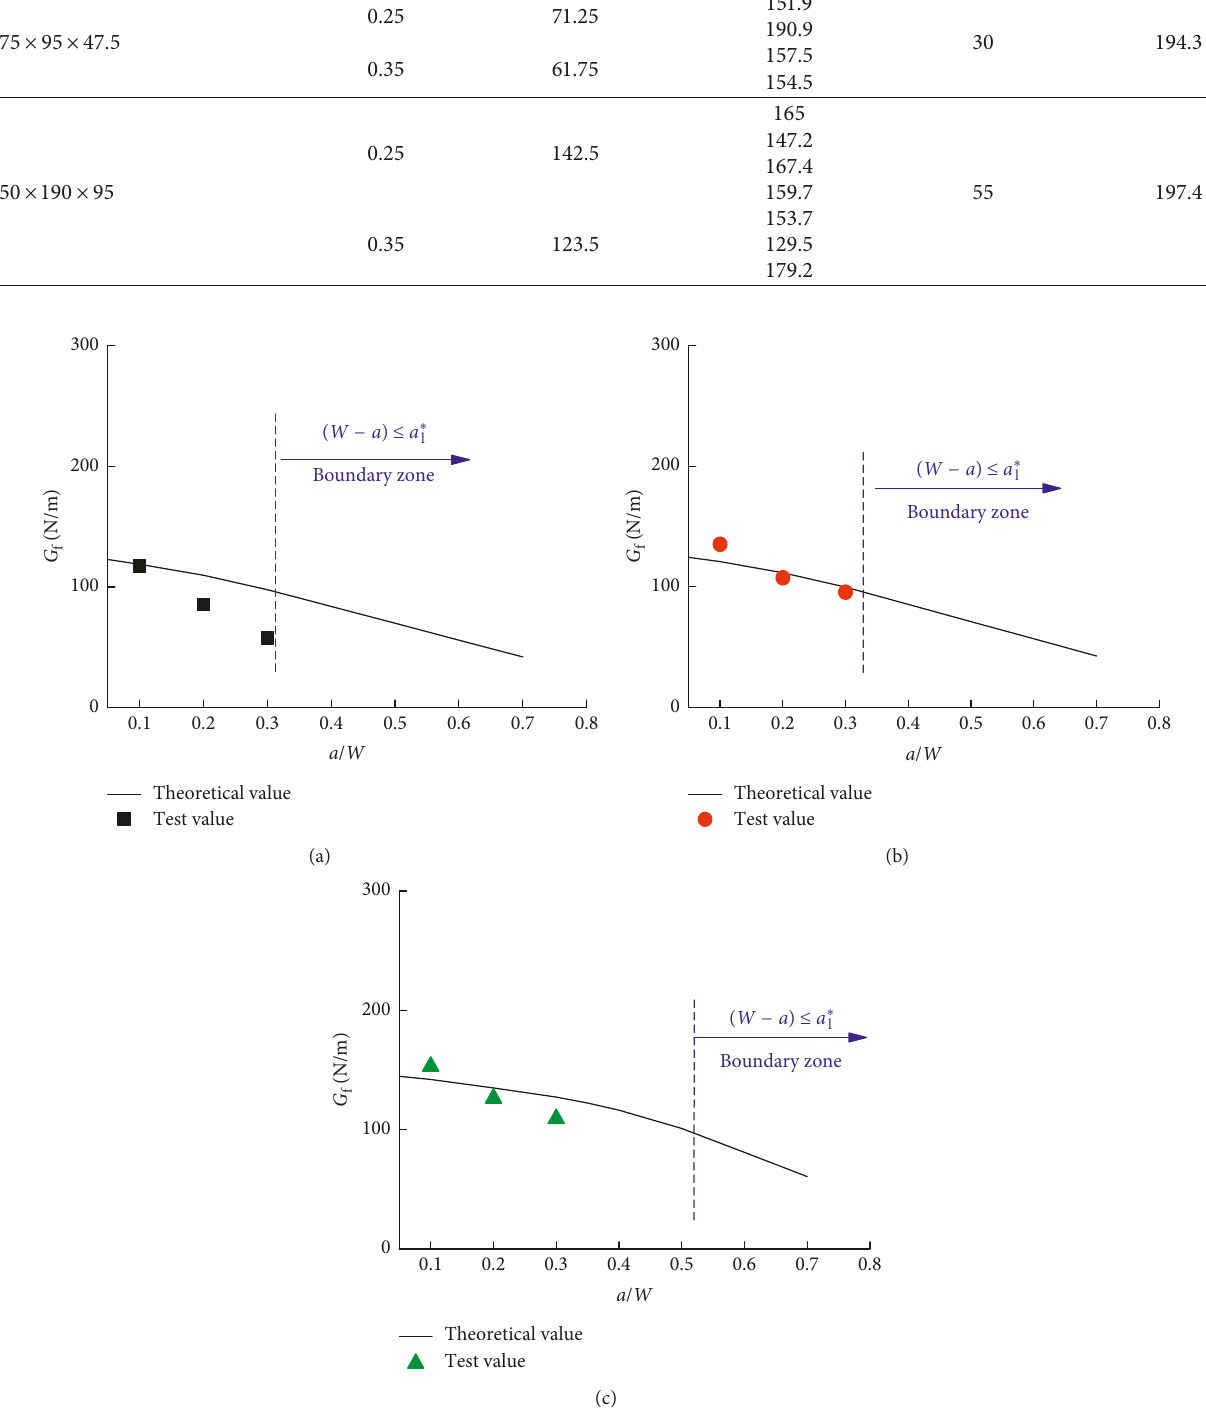
Figure 8: Comparisons of the theoretical with measured fracture energy in the study of Karihaloo et al. [22]. (a) Small size with S / W � 5 and W � 50mm. (b) Small size with S / W � 5 and W � 100mm. (c) Large size with S / W � 5 and W �